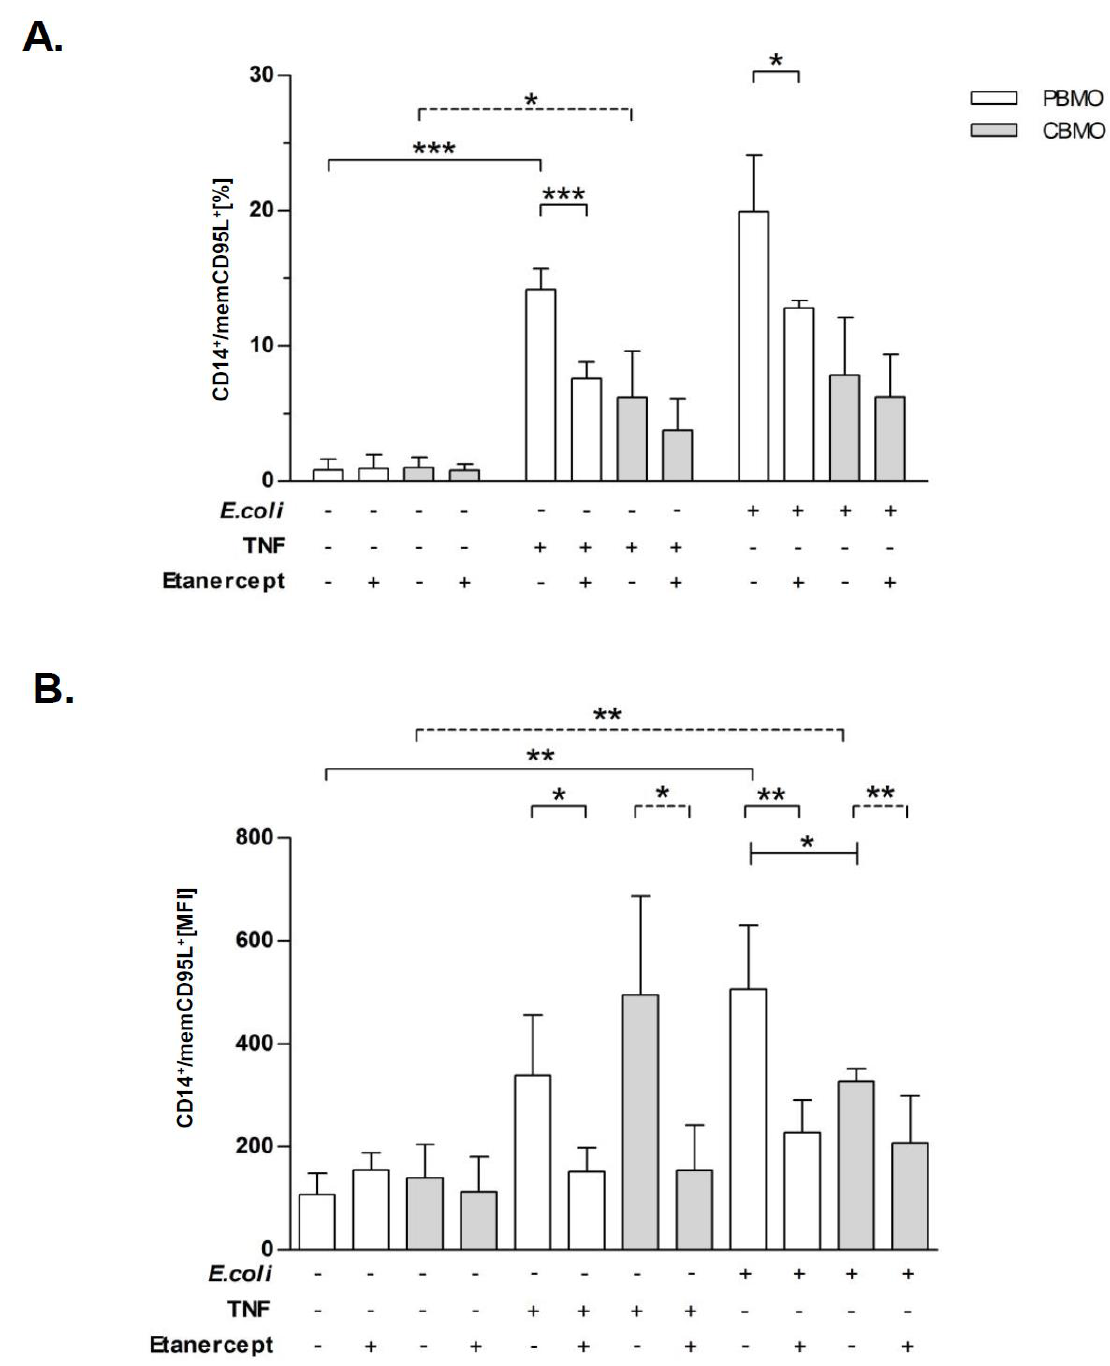
Figure 4. TNF triggers expression of CD95L. PBMO and CBMO were stimulated with TNF and/or infected with E. coli for four hours and analyzed for CD95L expression. Some groups were pre-treated with etanercept. The number of PBMO and CBMO expressing memCD95L were determined as the percentage ( A ) and the mean concentration given as the mean intensity (MFI), ( B ); for A and B, n = 5, * p < 0.05, ** p < 0.01, *** p < 0.001, forked bars represent Student’s t -test, blunt-ended bars represent ANOVA.